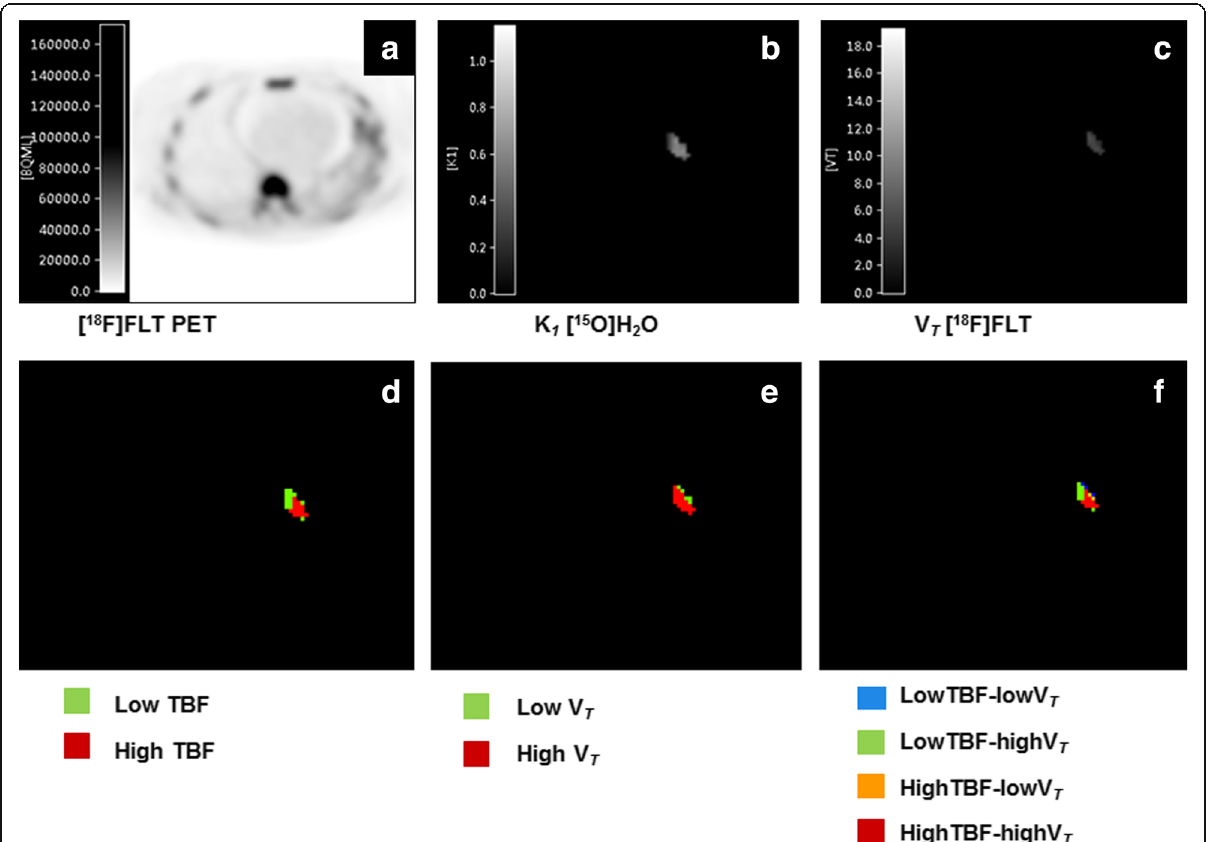
Fig. 3 An overview of the multiparametric evaluation of TBF and [ 18 F]FLT uptake. a [ 18 F]FLT PET scan. b Parametric VOI image of [ 15 O]H 2 O derived TBF. c Parametric VOI image of [ 18 F]FLT V T . d Voxels classified as low or high TBF. e Voxels classified as low or high [ 18 F]FLT V T . f Voxels classified into four categories: lowTBF-lowV T , lowTBF-highV T , highTBF-lowV T and highTBF-highV